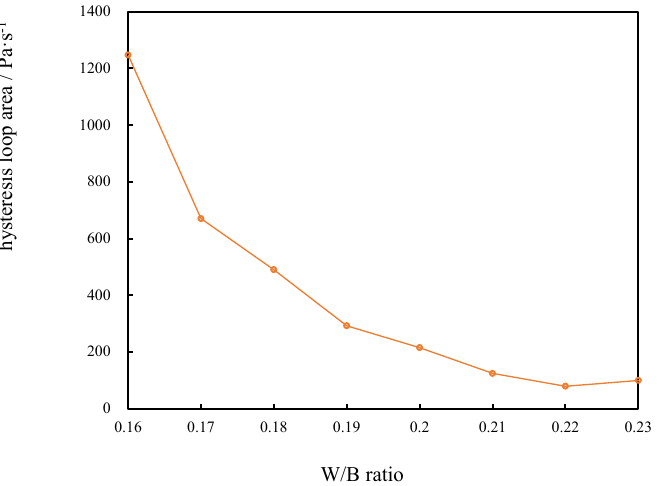
Figure 12. The relationship between the hysteresis loop area and W/B ratio of CSHWM.